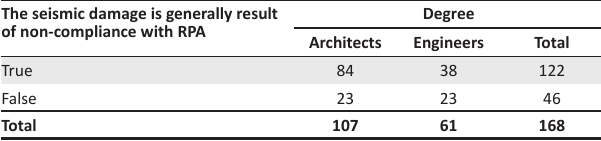
TABLE 16: Seismic damage and Algerian paraseismic rules – compliance. The seismic damage is generally result of non-compliance with RPA